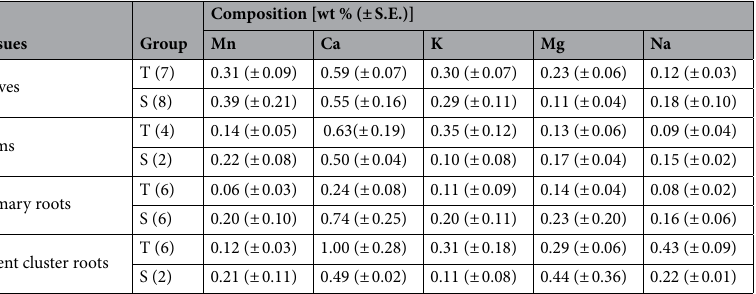
Table 2. Elemental composition in tissues of plants of Grevillea meisneri that had been grown in a nursery and then transplanted (T) and plants that had grown spontaneously (S) in the rehabilitation site, determined by MP-AES analyses (mean ± standard error). Numbers in brackets denote the separate samples analyzed. Ni was also analyzed but not